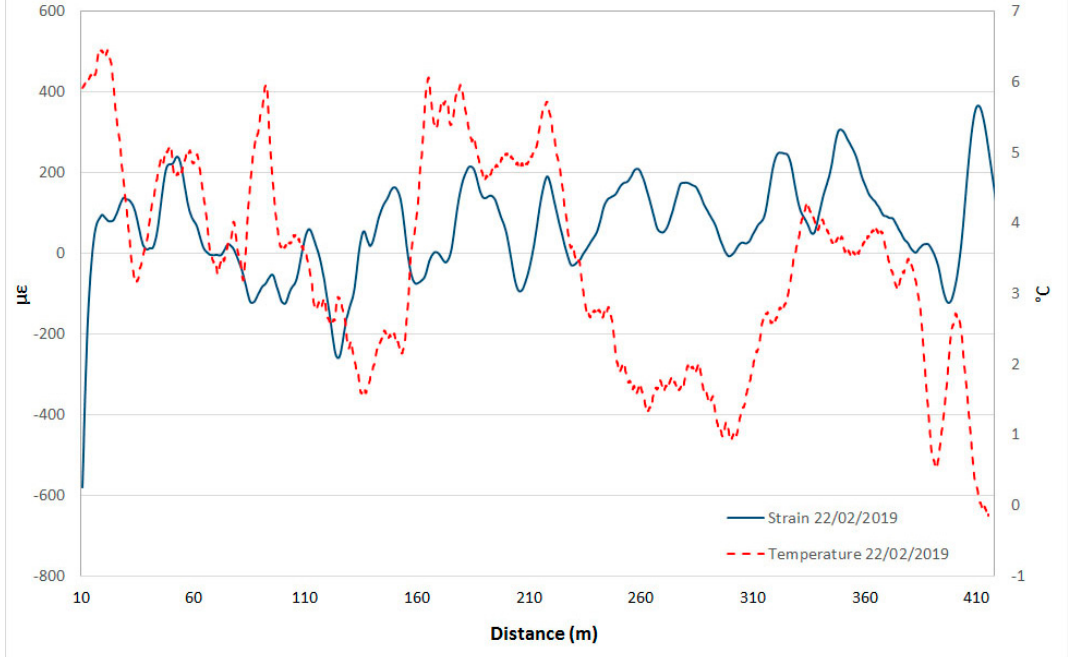
Figure 24. Example of comparison of strain and temperature profiles in winter.